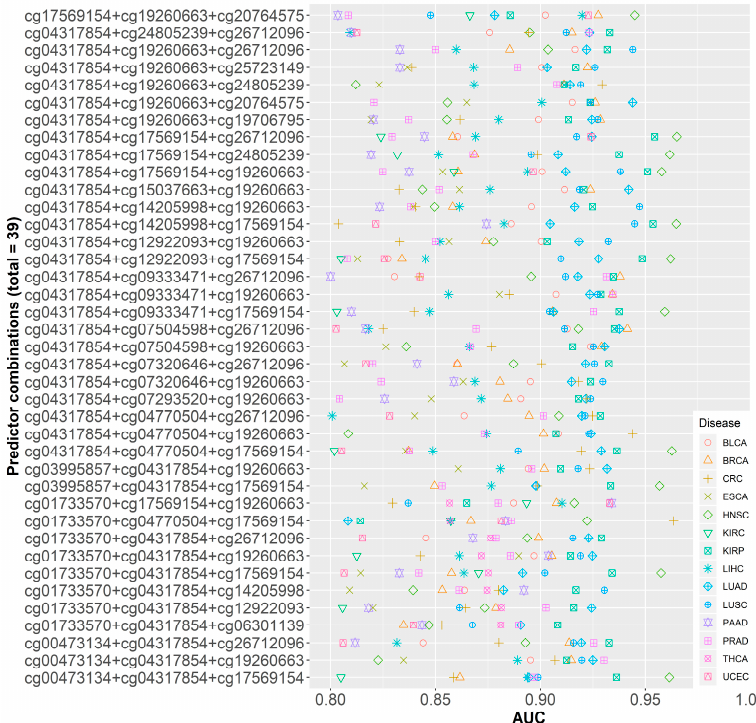
Figure 3. Cleveland plot of the calculated average area under the curves (AUCs for 39 probe combinations that satisfy both filters (minimum average AUC = 0.84 and minimum AUC threshold = 0.80) across the datasets.